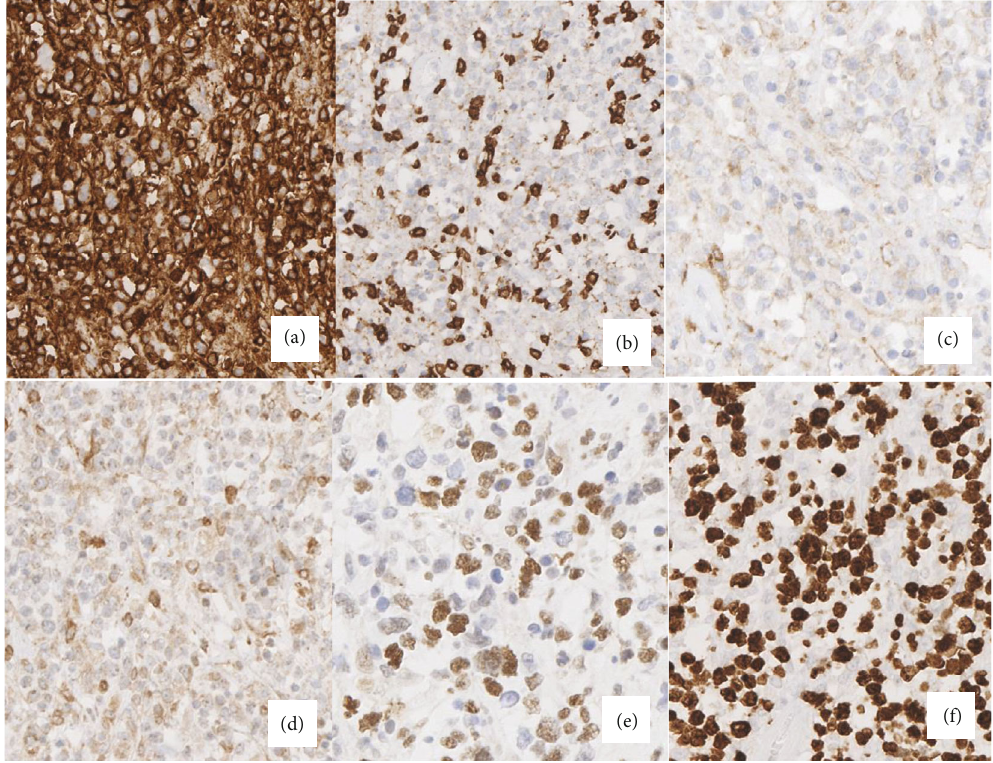
Figure 2: Immunohistochemical stains (400x) show that the atypical lymphocytes are positive for CD20 (a), negative for CD3 (b), weakly positive for CD10 (c), weakly positive for BCL2 (d), and positive for BCL 6 (e), with increased Ki-67 proliferation index at 80%